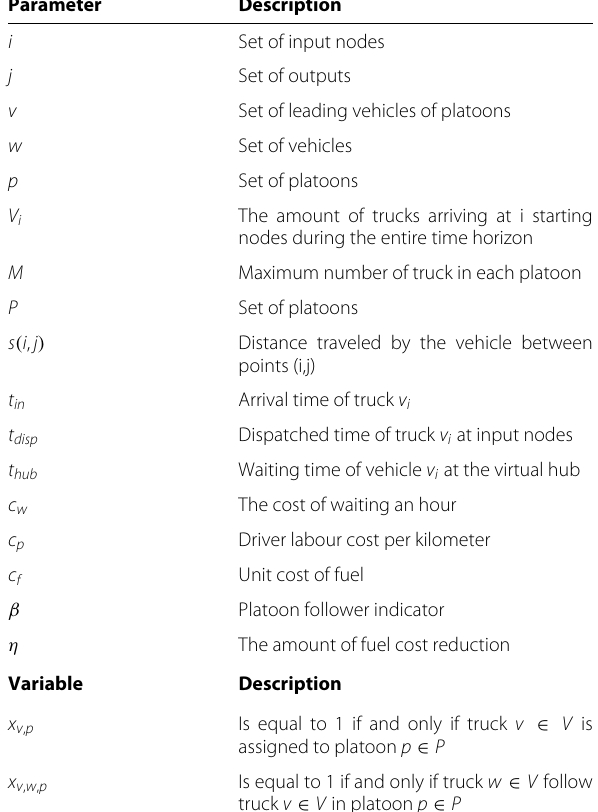
Table 1 Mathematical